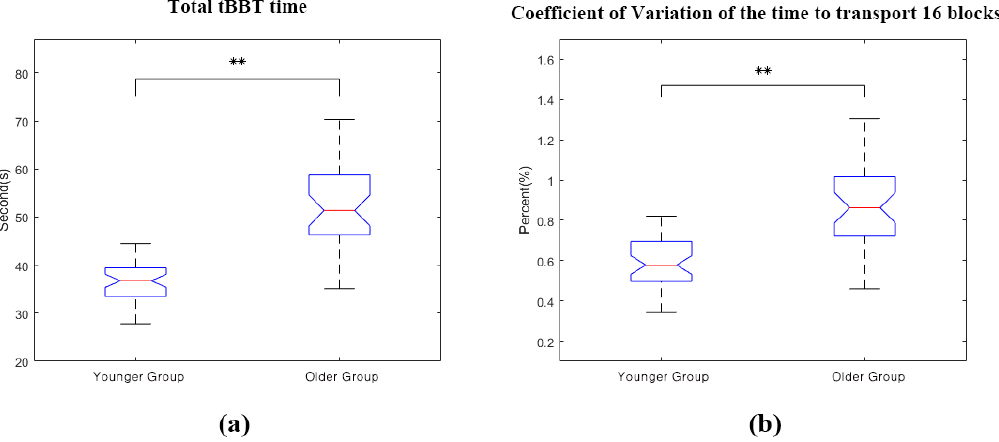
Figure 6. Performance parameters in the tBBT by age: ( a ) the total tBBT time and ( b ) Coefficient of Variation of the time to transport 16 blocks (** p < 0.01).